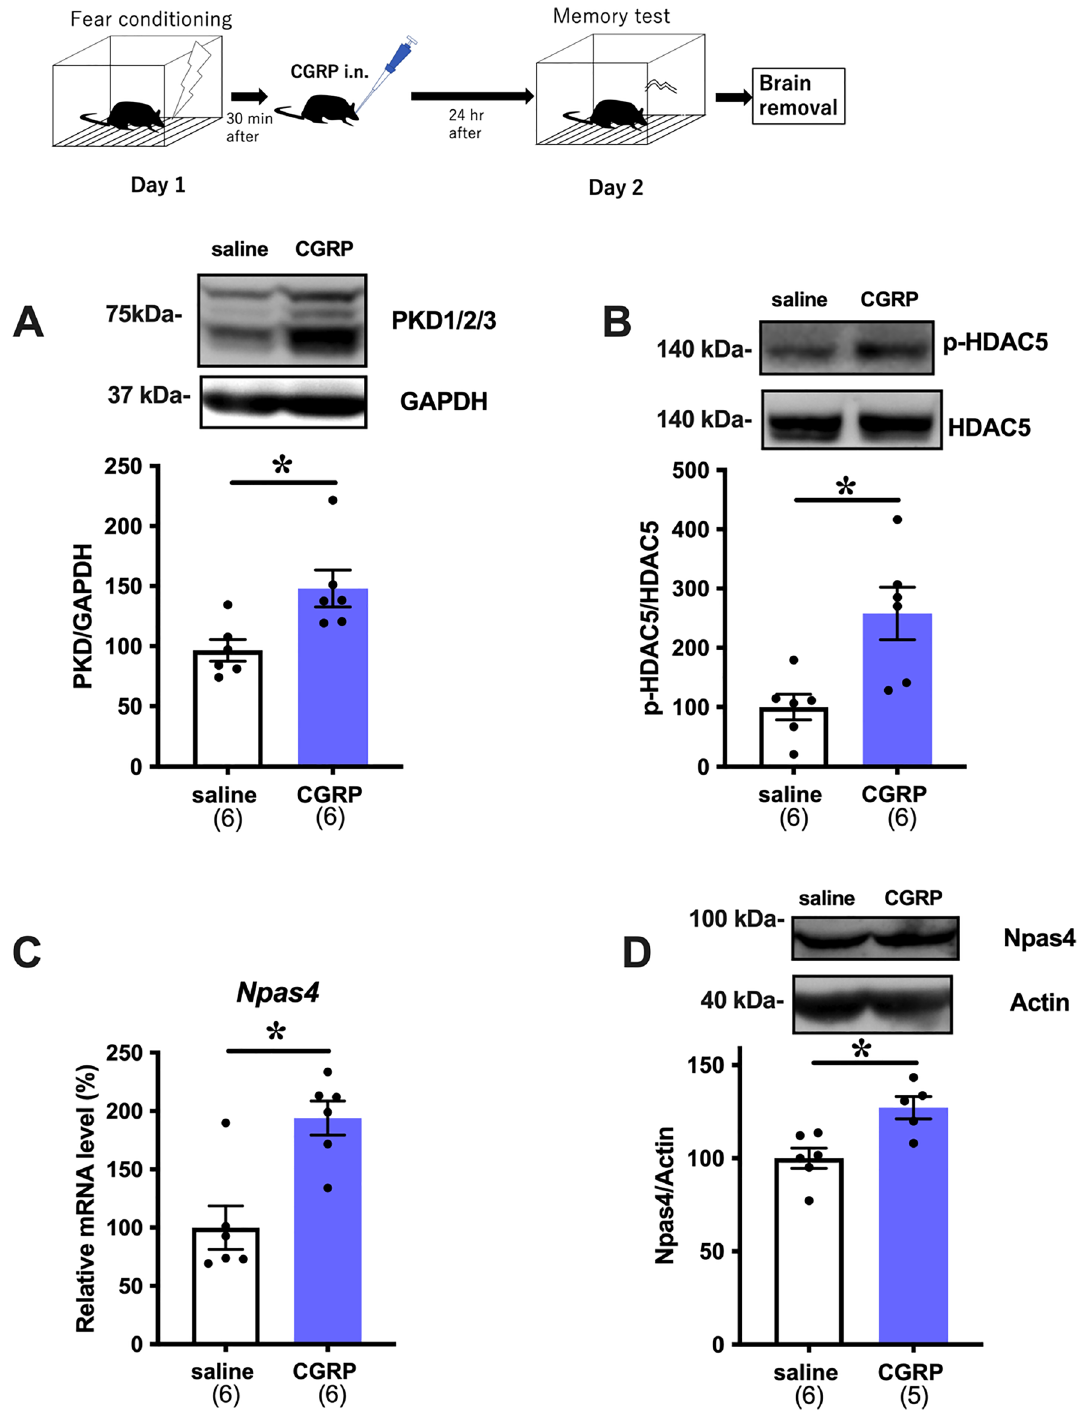
Figure 3. Effects of intranasal administration of CGRP on the PKD/p-HDAC5/Npas4 pathway. ( A ) PKD protein levels in saline and CGRP-treated mice, ( B ) Phosphorylated HDAC5 expression in saline and CGRP- treated mice, ( C ) Npas4 mRNA levels in saline and CGRP-treated mice, and ( D ) Npas4 protein expression in saline and CGRP-treated mice. Each bar indicates the mean ± S.E.M. * p < 0.05, Welch’s t test. Numbers in parentheses indicate the animal numbers for each